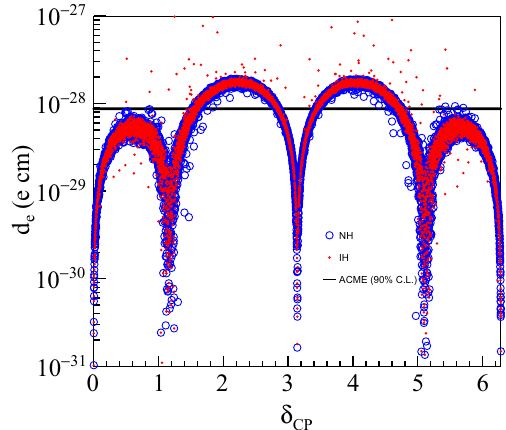
Fig. 13 Electric dipole moment, d e as a function of Dirac CP-phase, δ CP for NH and IH patterns of light neutrino masses considering diago- nal structures for Dirac neutrino mass matrix M D and N R − S L mixing matrix